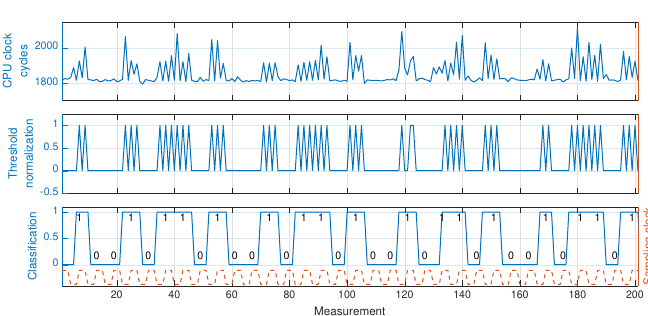
Figure 13: Covert channel measurements and decoding. The AFU sends each bit three times, which results in three peaks at the receiver if a ‘ 1 ’ is transmitted (middle